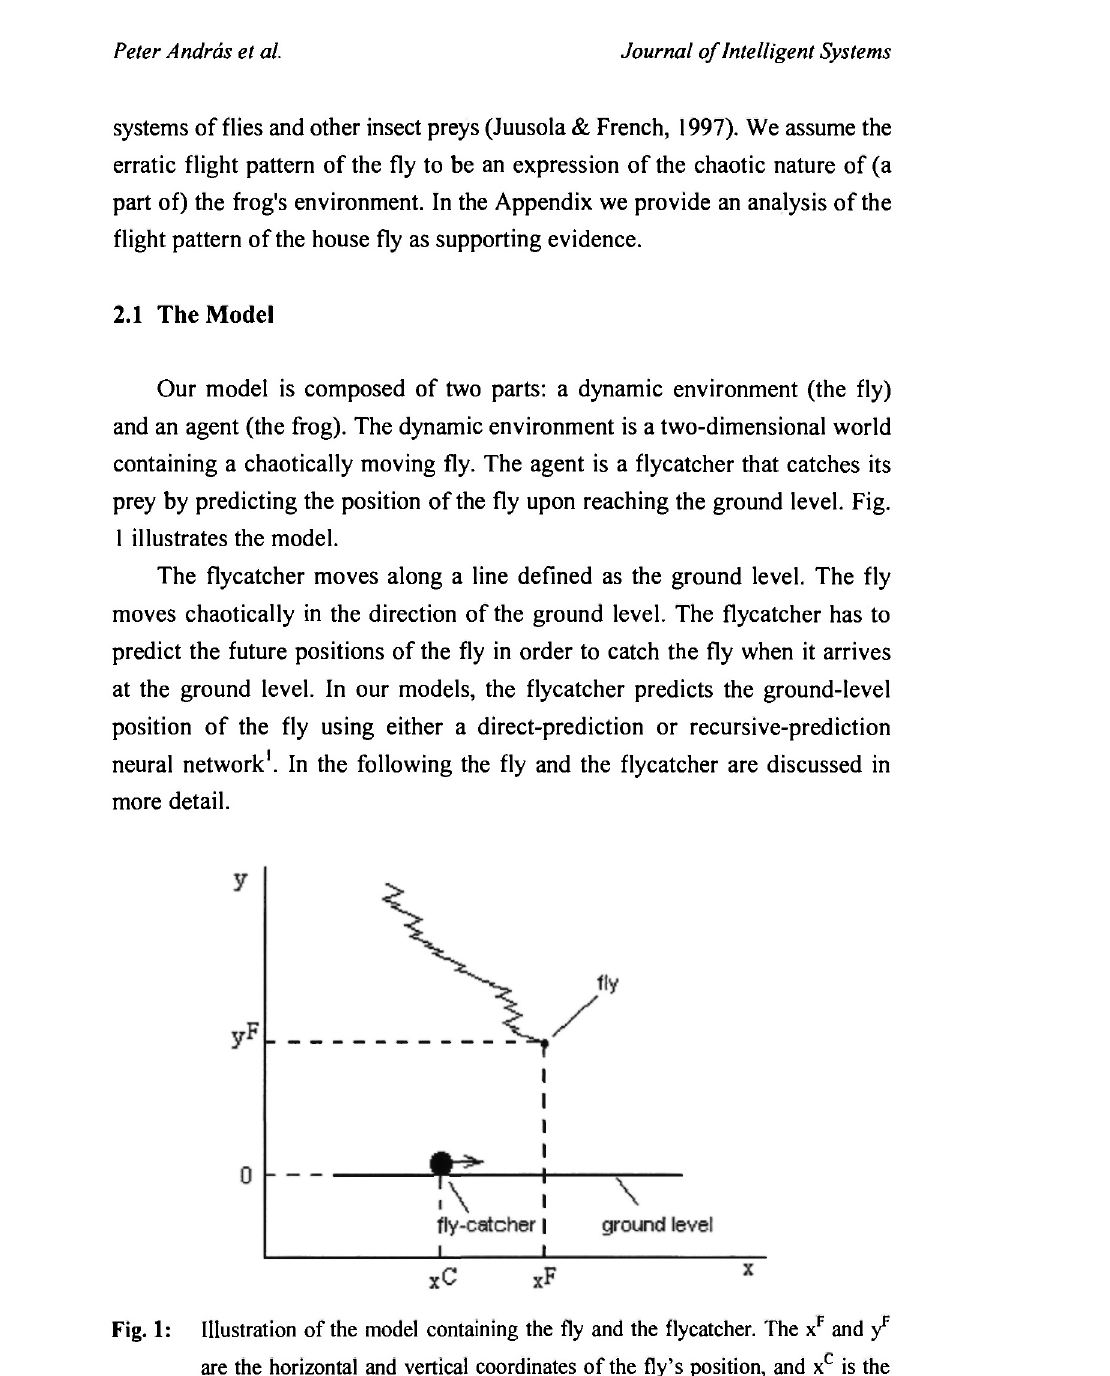
Illustration of the model containing the fly and the flycatcher. The x F and y F